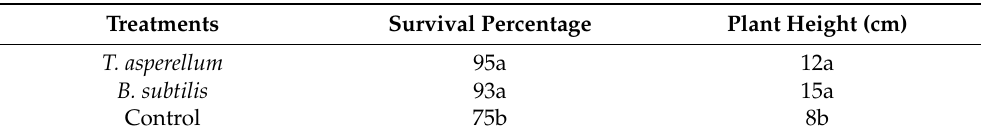
Table 2. Survival percentage and growth of microplants of M. spicata biotized with T. asperellum and B. subtilis during the acclimatization